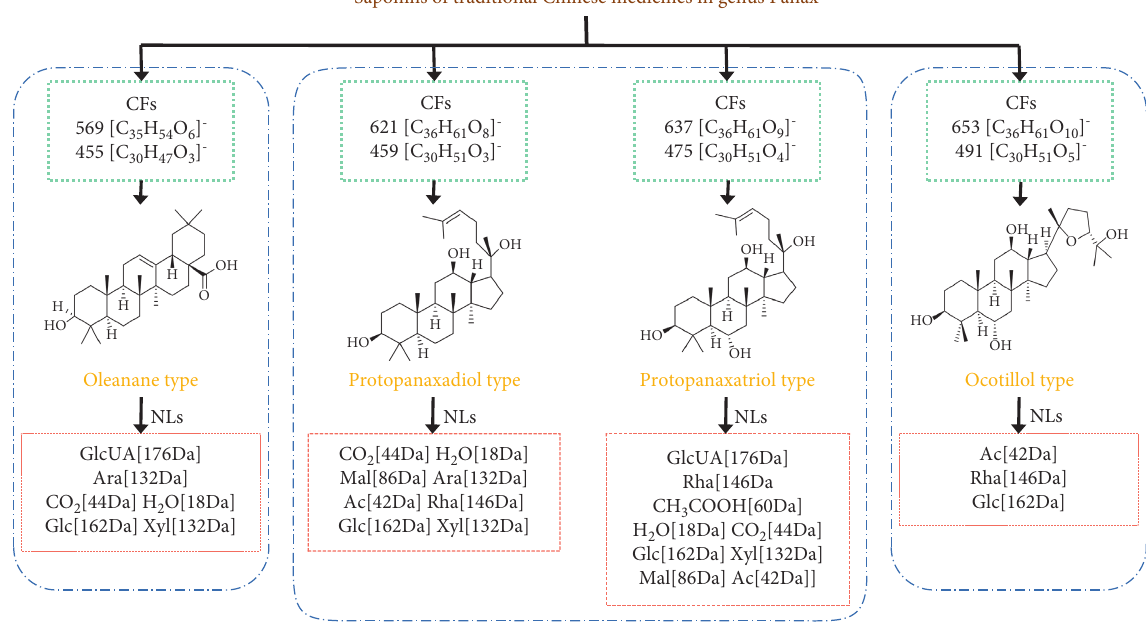
Figure 2: Characteristic fragments and neutral losses of different types of saponins in genus Panax . Ac: acetyl; Mal: malonyl; Glc: glucose residue; Ara: arabinose residue; Rha: rhamnose residue; Xyl: xylose residue; GlcUA: glucuronic acid.